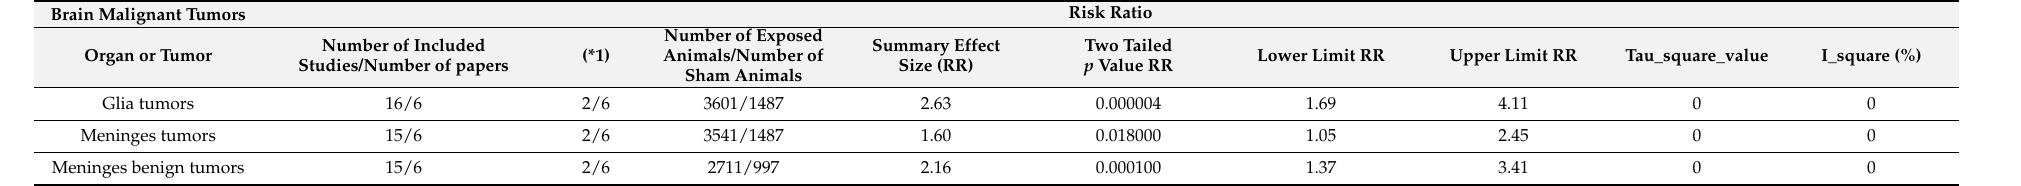
Table 5. Summary table of the meta-analysis results carried out on glia and meninges malignant and benign tumors. RR values with the relative limits of variability (CI 95%) and p -value are reported for each sample.